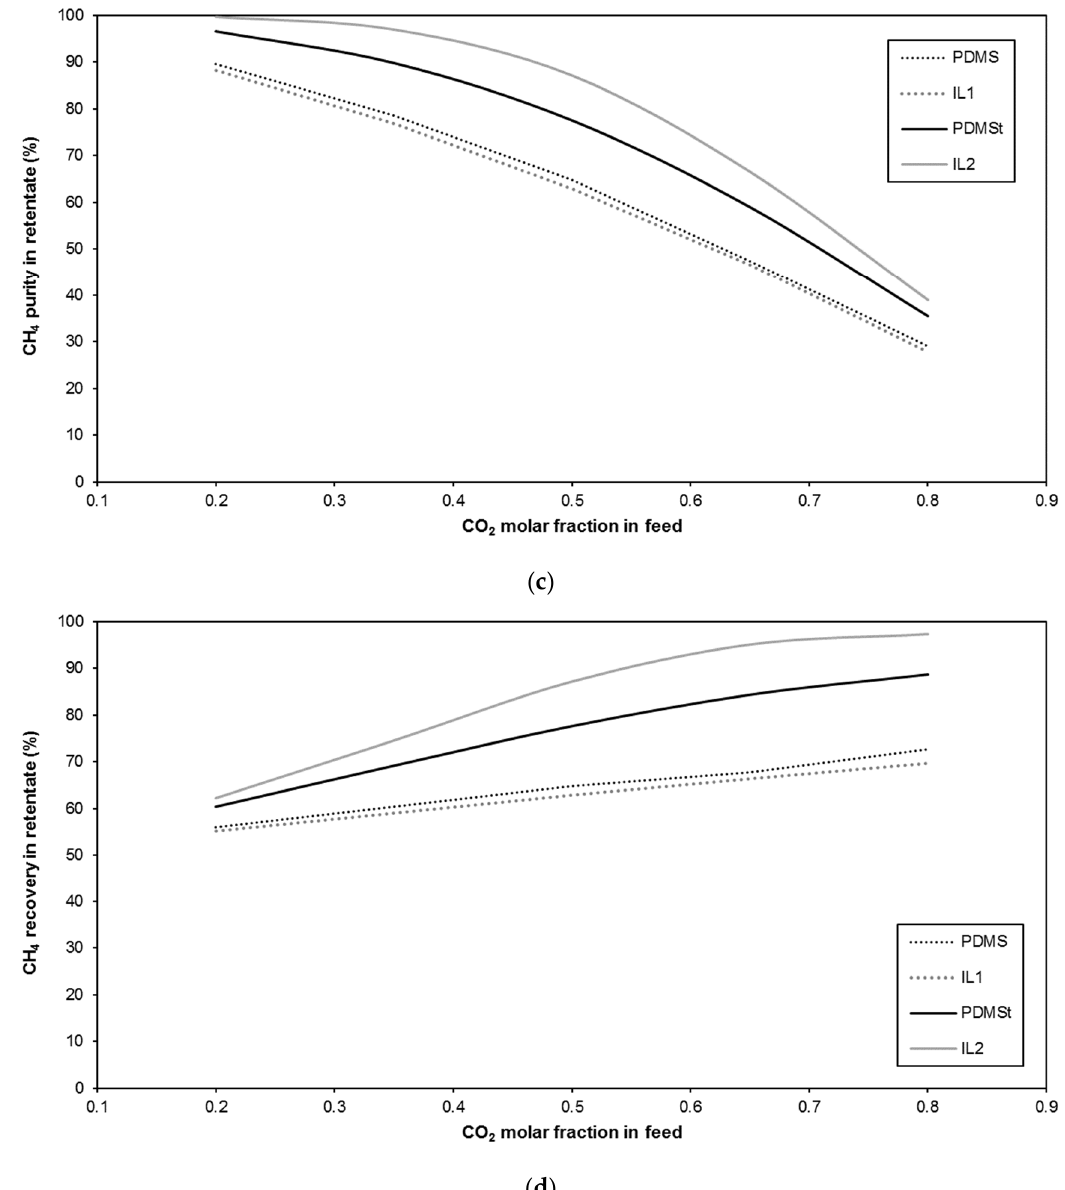
Figure 6. Influence of the feed CO 2 molar fraction on ( a ) CO 2 purity, ( b ) CO 2 recovery, ( c ) CH 4 purity and ( d ) CH 4 recovery for the different membranes (P F = 4 atm, P Q = 1 atm, stage cut = 0.5).